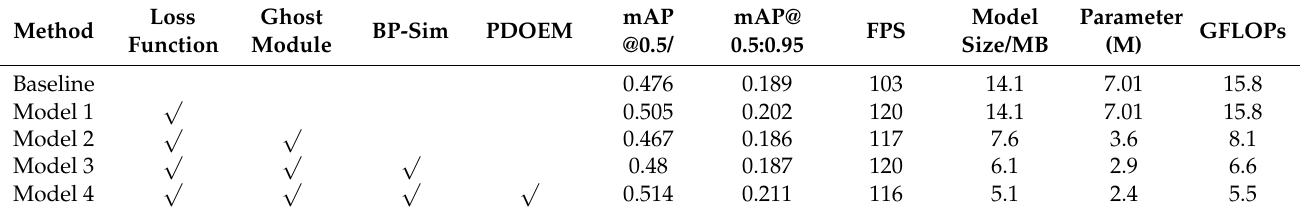
Table 6. Batchsize = 1, image size =